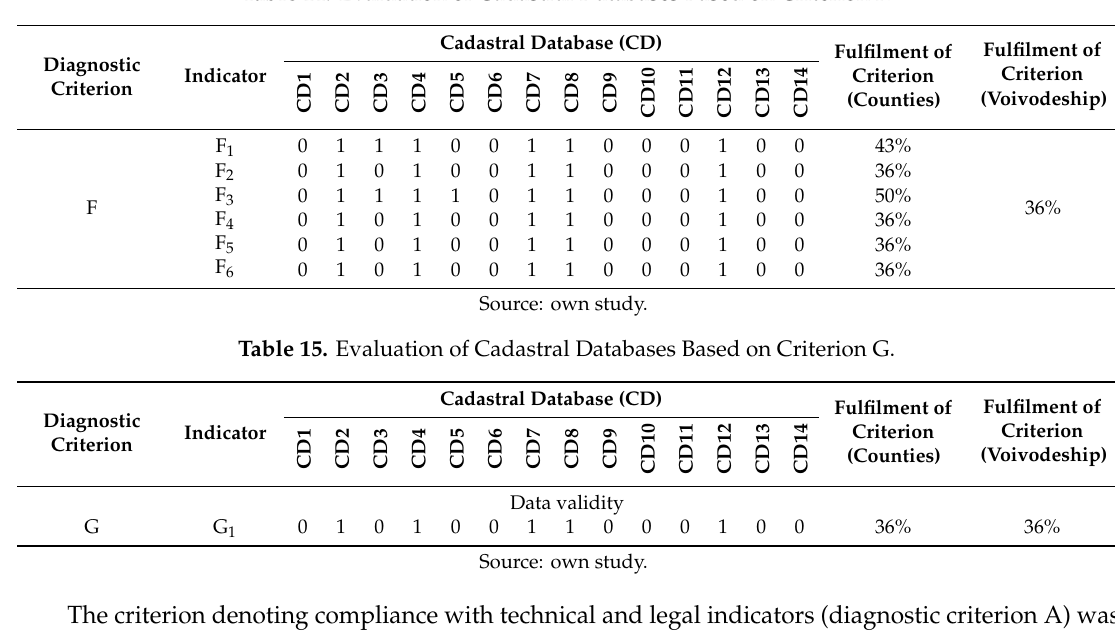
Table 14. Evaluation of Cadastral Databases Based on Criterion F.